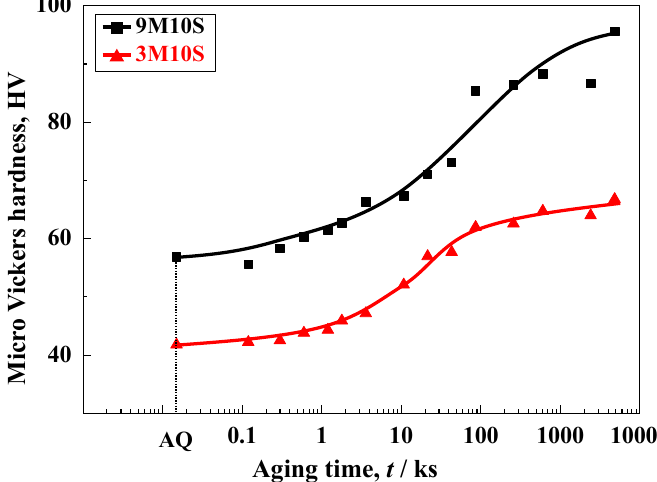
Figure 2. Hardness changes during natural aging in the 3M10S and 9M10S. AQ represents as-quenched.